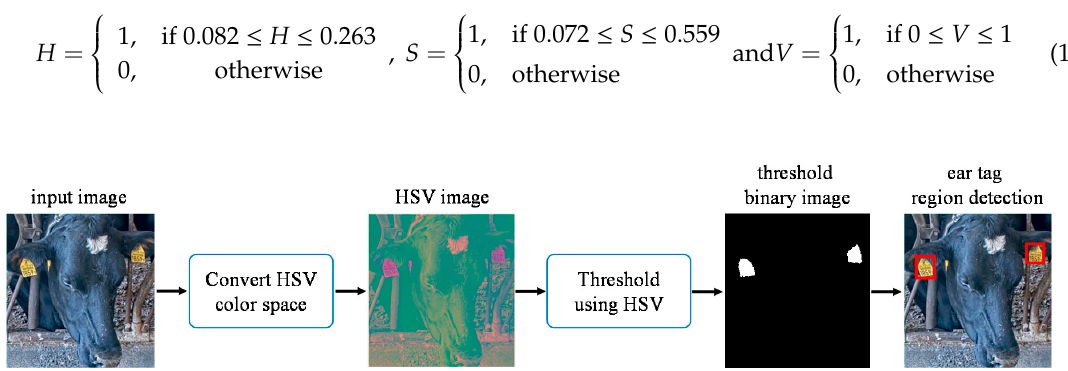
Figure 4. Ear tag region detection from the head image.